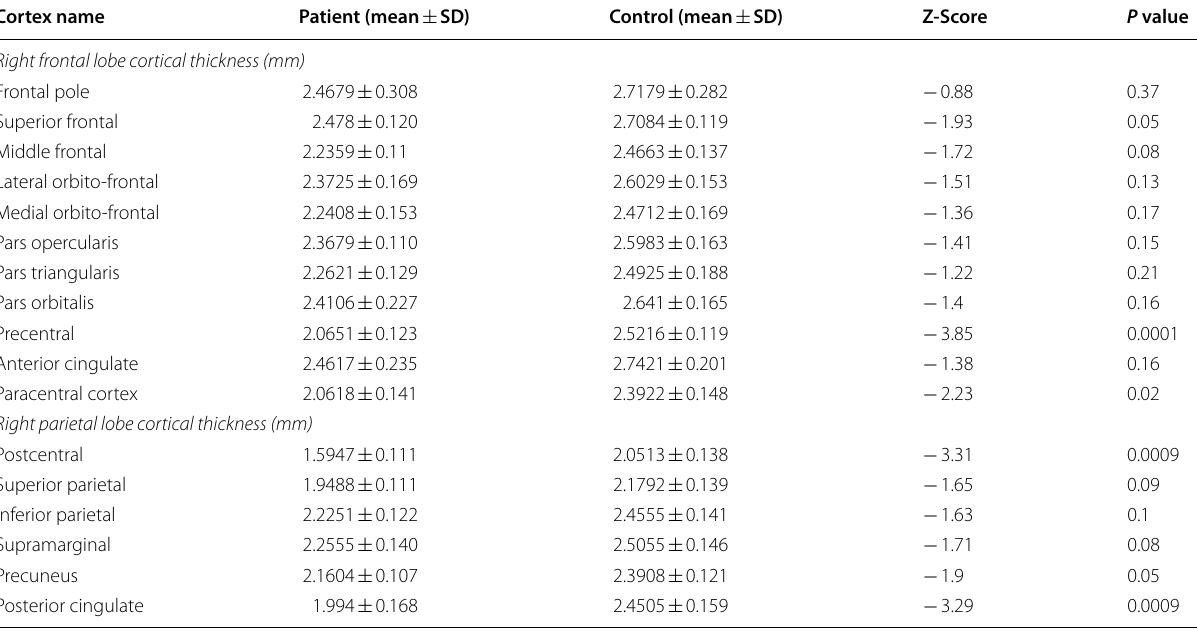
Table 5 Quantitative results of the cortical thickness in mm of the right frontal and parietal lobe areas in mm for patients and control groups, Z-scores and P values